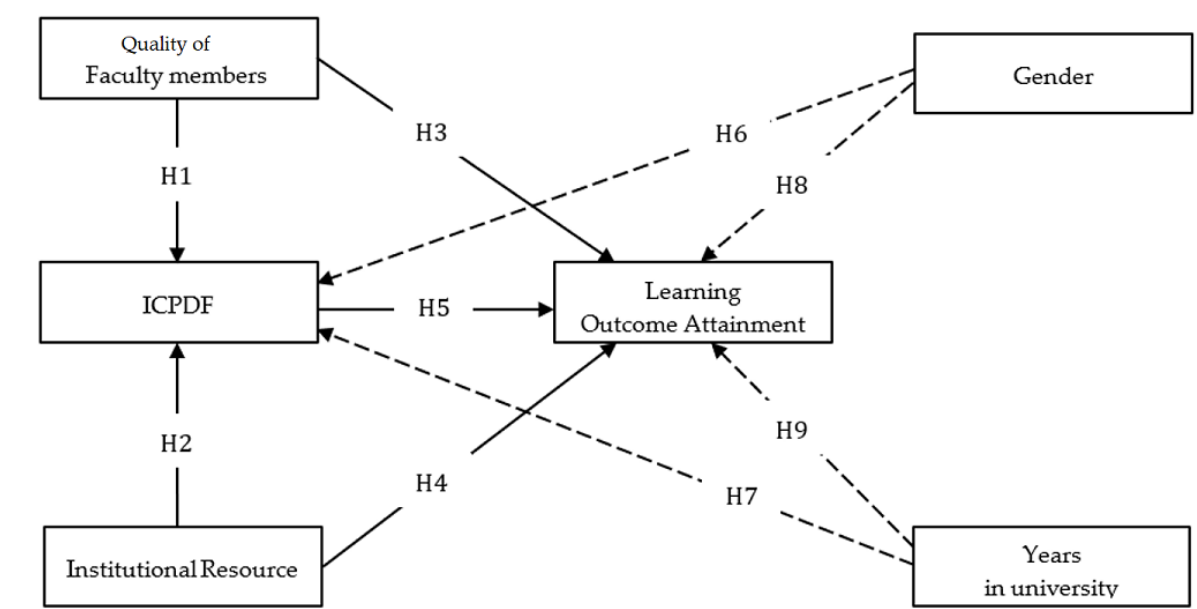
Figure 1. ICPDF evaluation model.